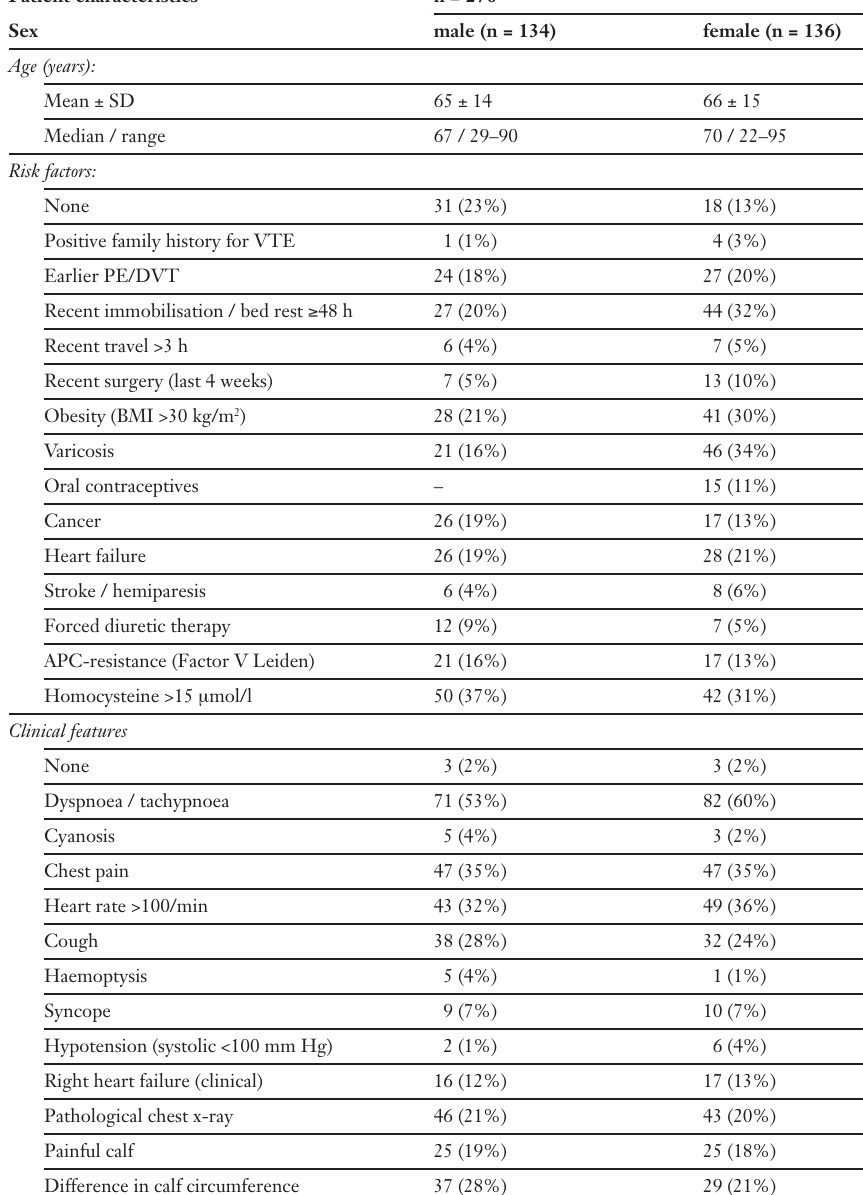
Table 1 Patient